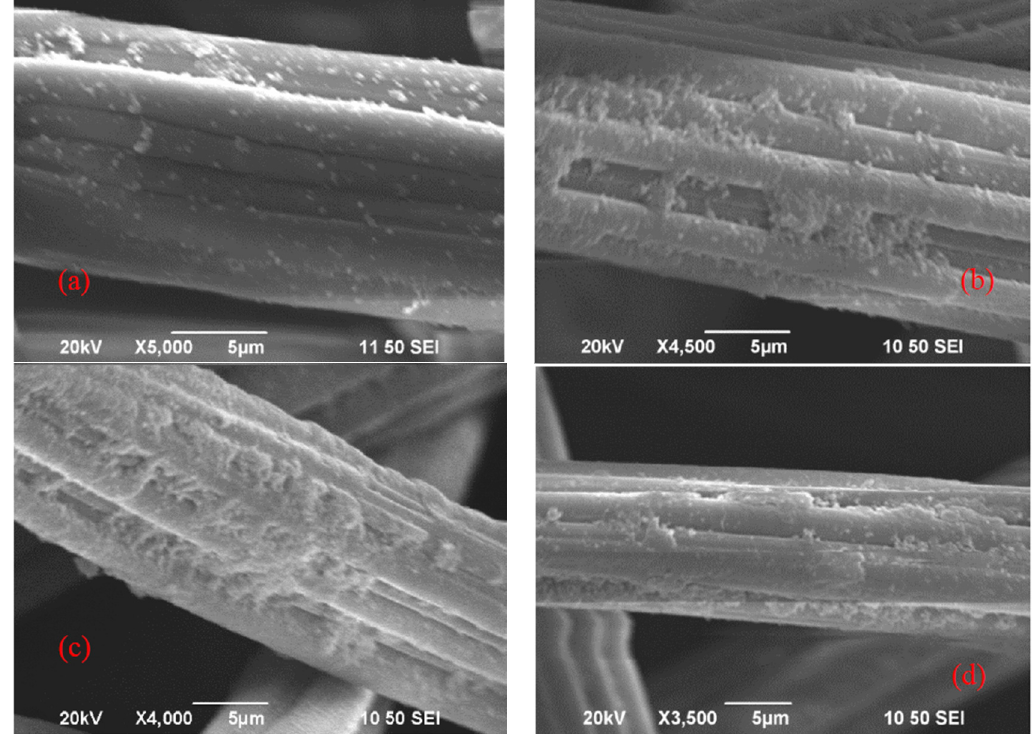
Figure 5. SEM micrographs illustrate the surface morphology of rayon flock synthetic leather after TMS plasma treatment with different treatment times: ( a ) 10 s, ( b ) 20 s, ( c ) 30 s, ( d ) 40 s (treatment parameters: amount of TMS = 0.2 mL; flow rate of helium = 12.5 LPM; jet distance = 10 mm; discharge power = 50 W).